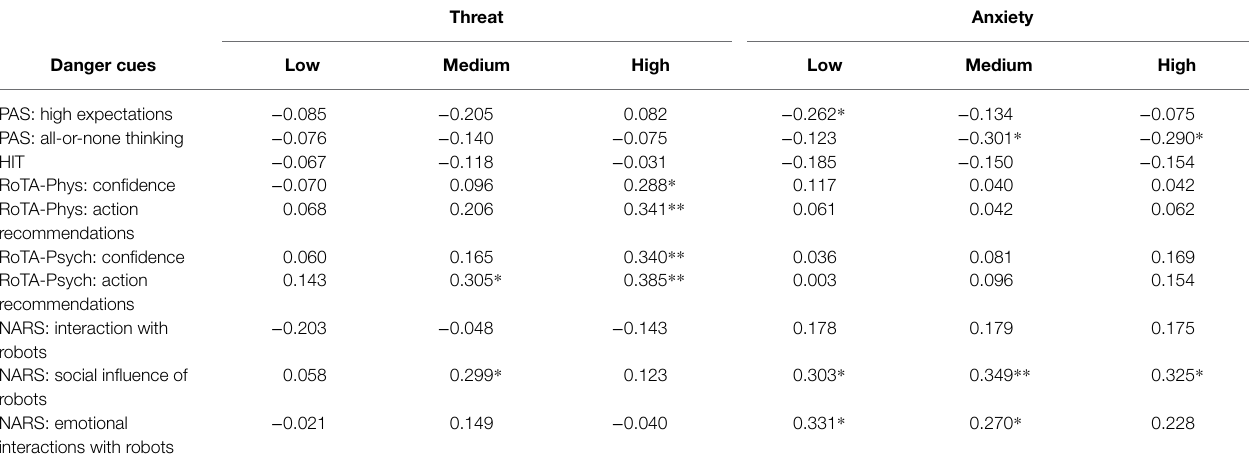
TABLE 6 | Correlations between dispositional measures and threat and anxiety ratings at three levels of danger cues, in psychological condition. Threat Anxiety